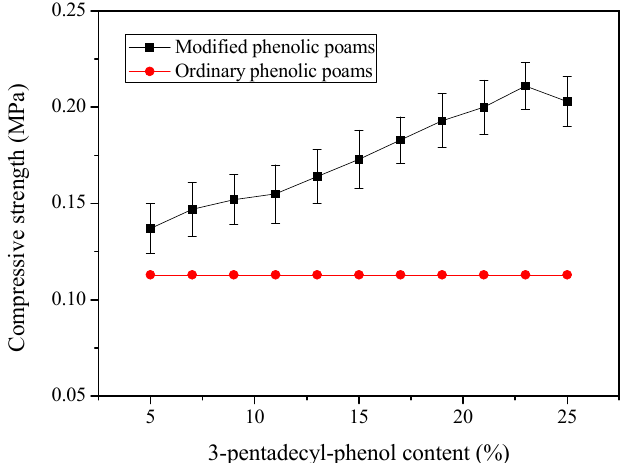
Figure 7. Compressive strength of modified phenolic foams as a function of 3-pentadecyl-phenol, reproduced from [21] under open access license.